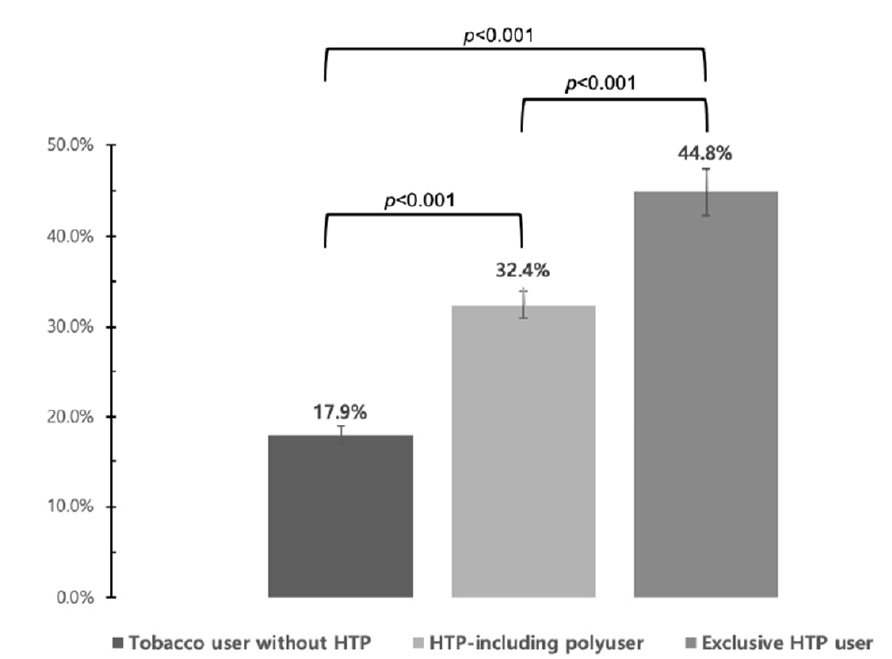
Figure 1. Proportion of those who answered that heated tobacco products are less harmful than conventional cigarettes. Three groups were compared in pairs using chi-square tests with Bonferroni correction for multiple comparison ( p < 0.017). Abbreviation: HTP, heated tobacco